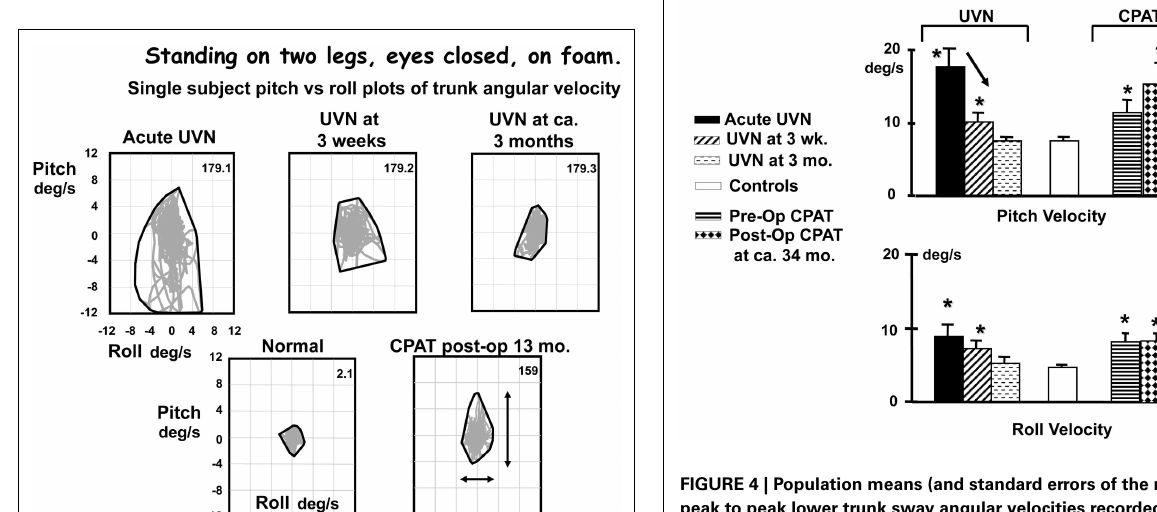
FIGURE 4 | Population means (and standard errors of the means) of peak to peak lower trunk sway angular velocities recorded while performing the task of standing on foam with eyes closed. The subject data is from patients with an acute unilateral vestibular neuritis (UVN), healthy controls, and patients pre- and post-CPAT surgery.The CPAT removal involved an eighth nerve neurectomy.The means were from 28 acute UVN subjects, 26 of these at 3weeks, 20 at 3months, and 26 patients pre- and 14 patients post-CPAT surgery.These subjects’ means were compared with 100 age- and gender-matched healthy controls. Significant differences to means of controls are marked with asterisks, and significant changes over time with an arrow. Note the sway velocities larger than controls for the first weeks after the acute onset of UVN. Data from Allum et al. (2001), Allum and Adkin (2003), Beule and Allum